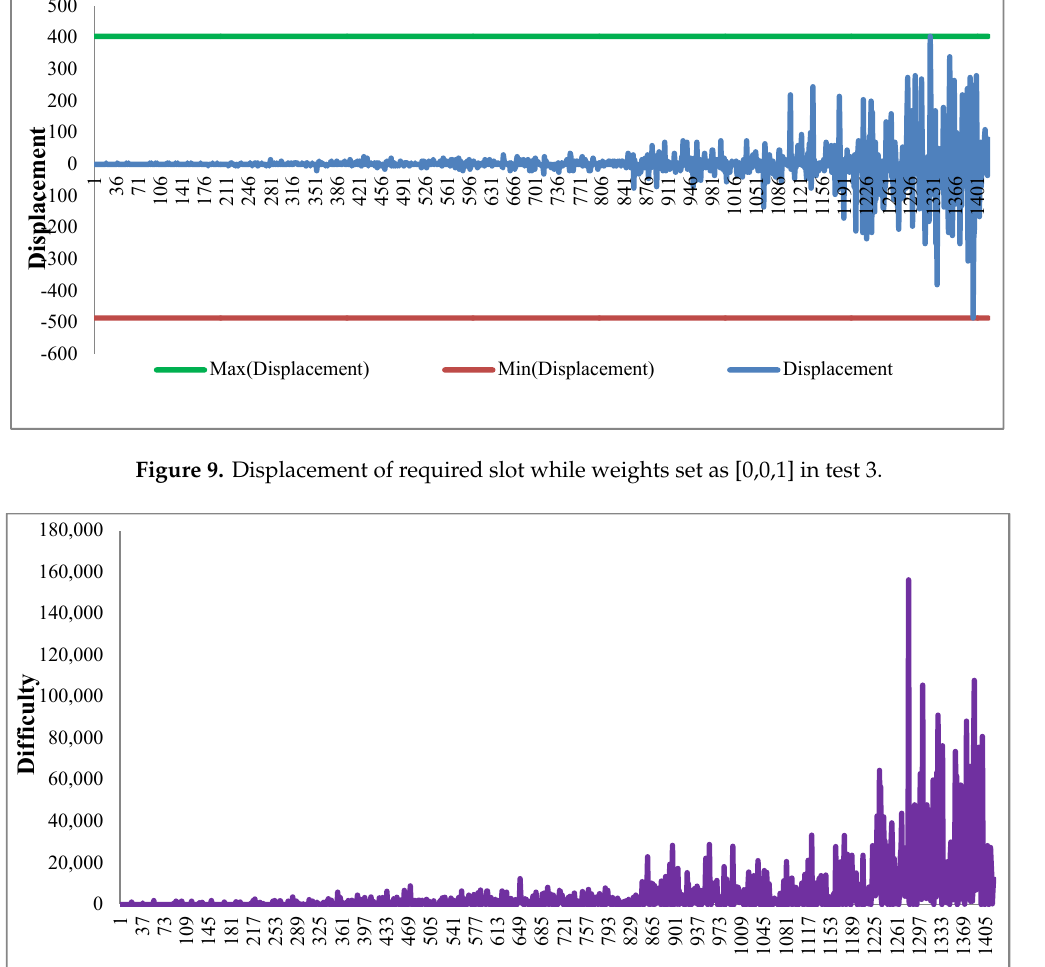
Figure 9. Displacement of required slot while weights set as [0,0,1] in test 3.